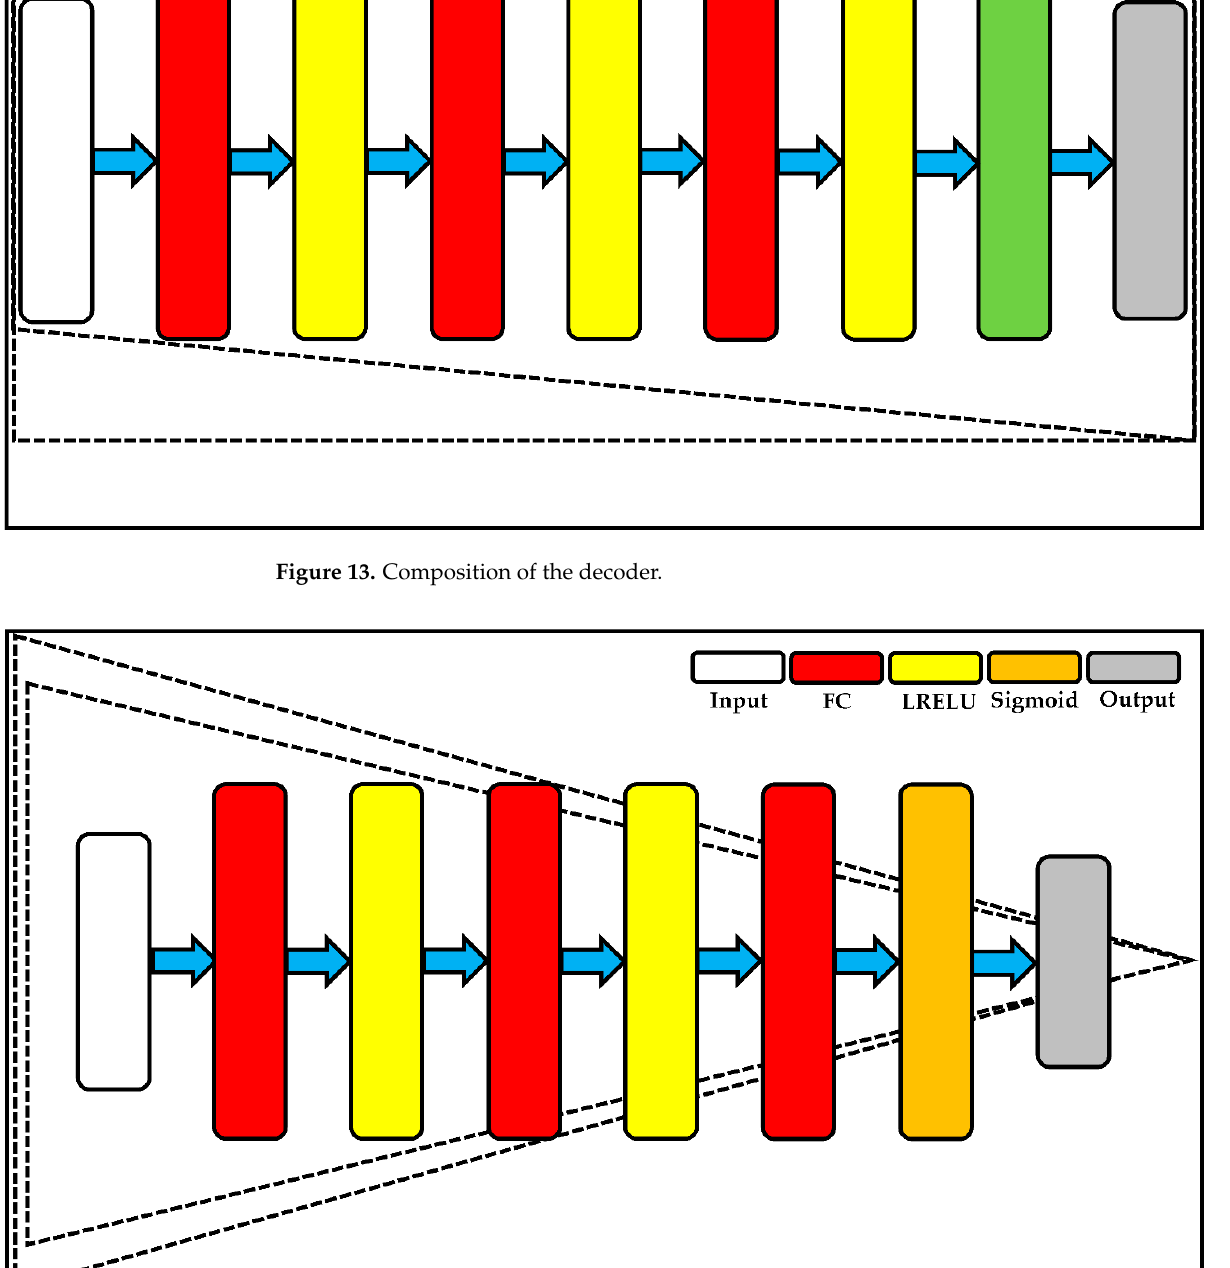
Figure 14. Composition of the discriminator.